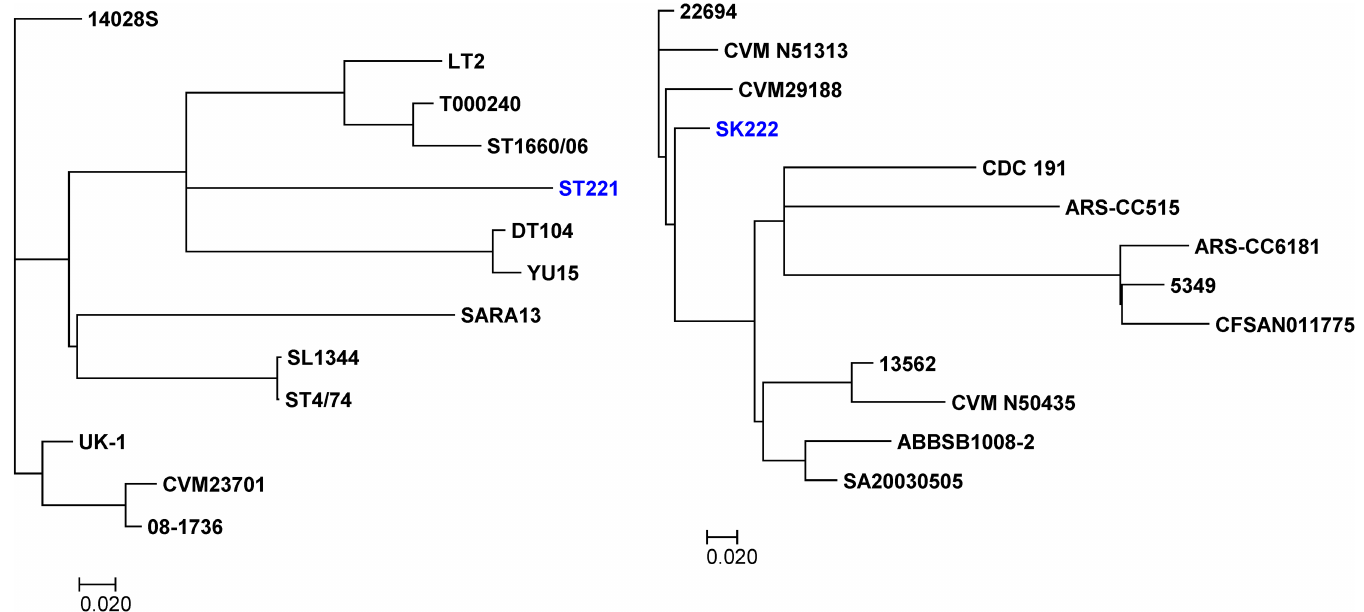
Fig 2. SNP-based phylogenetic tree. (A) Salmonellaenterica serovar Typhimurium (ST221_31B) and (B) Salmonella enterica serovar Kentucky (SK222_32B) constructed using 2,432 (ST19) and 650 (ST152) SNPs identifiedwithin each group,